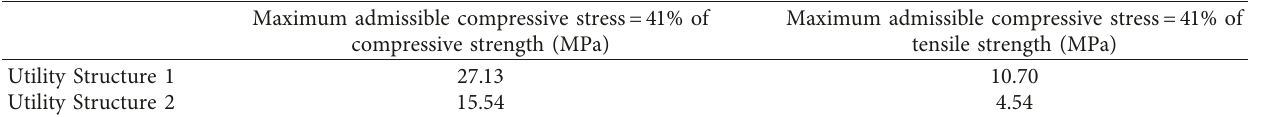
Table 9: Limit values of compressive and tensile stress.